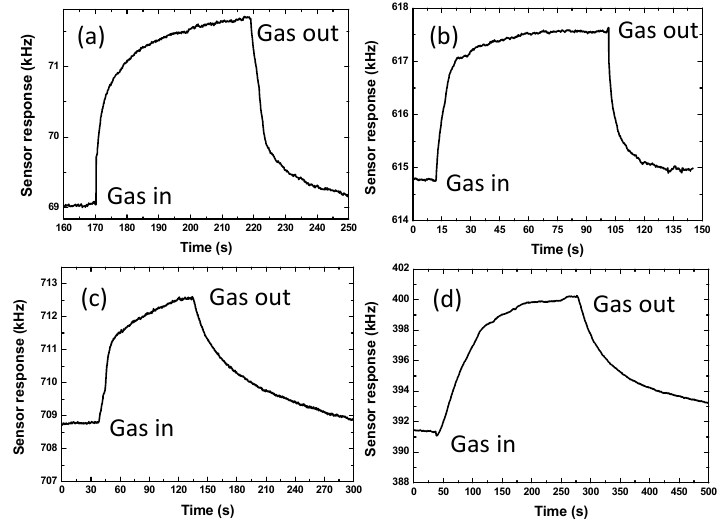
Figure 5. The measured sensor response towards 0.1% hydrogen gas employing the sensing devices coated with different Pd-Ni alloy thin-film thicknesses: ( a ) 10 nm; ( b ) 40 nm; ( c ) 60 nm; ( d ) 300 nm.